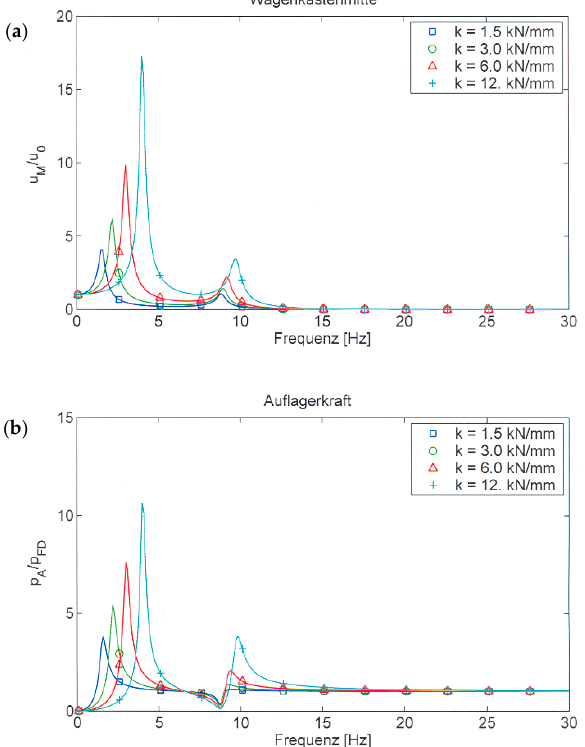
Figure 8. Calculated ( a ) displacements at mid-car related to the in-phase support motion and ( b ) suspension forces compared to the suspension forces of a fixed car body, variation of the suspension stiffness.